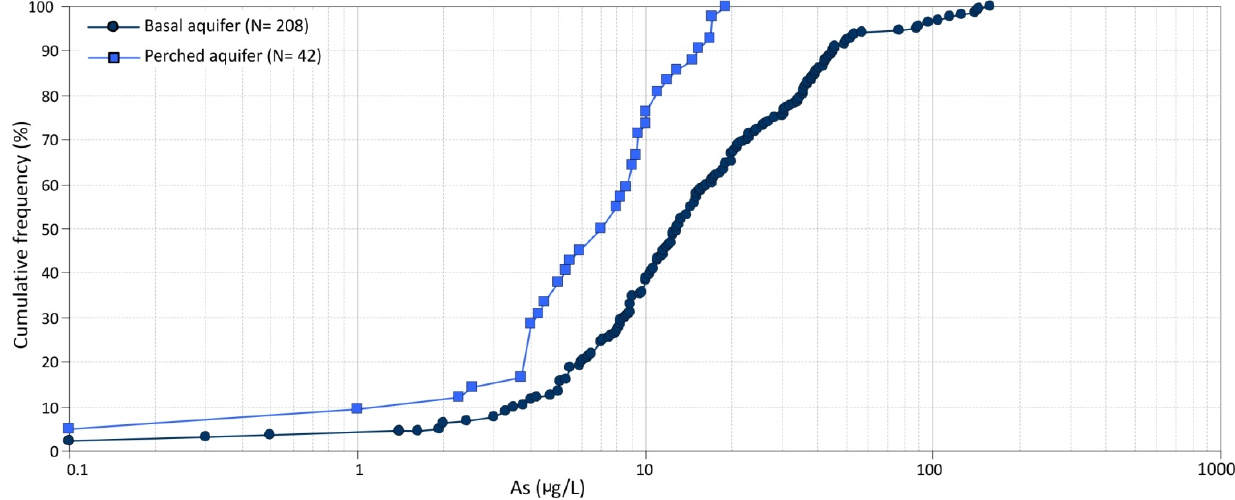
Figure 4. Cumulative frequency plots of arsenic concentrations in groundwater of basal and perched/dome-impounded aquifers.